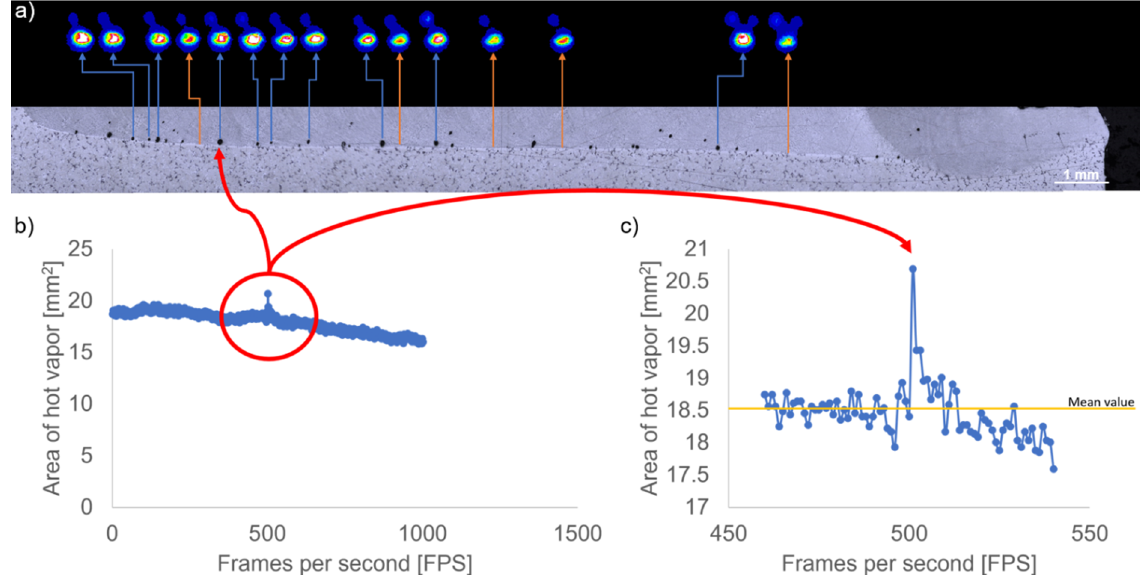
Figure 8. ( a ) Hot vapor plume variation during laser welding of AlMg3 and its correlation with pores appearance, ( b ) plot of hot vapor area variation in a selected range of frames for chosen pore and ( c ) a magnified view for highlighted regime in ( b ).